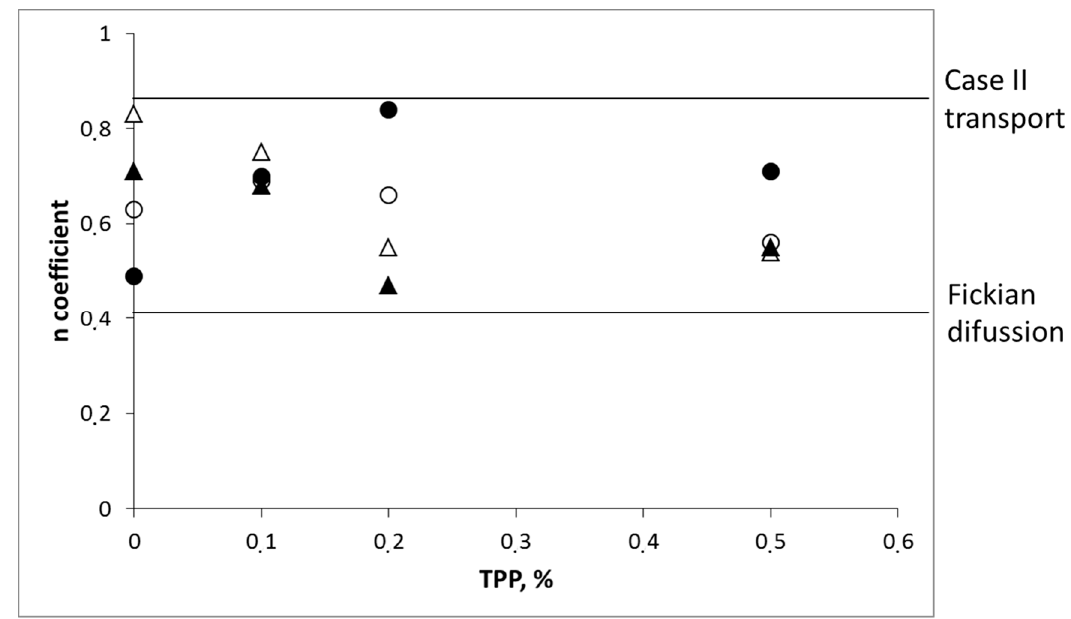
Figure 6. n values of the Korsmeyer–Peppas equation vs. TPP concentration. Formulations based on CS-1 (open symbols). Formulations based on CS-2 (close symbols). Simulated gastric fluid (circles) and simulated intestinal fluid (triangles).